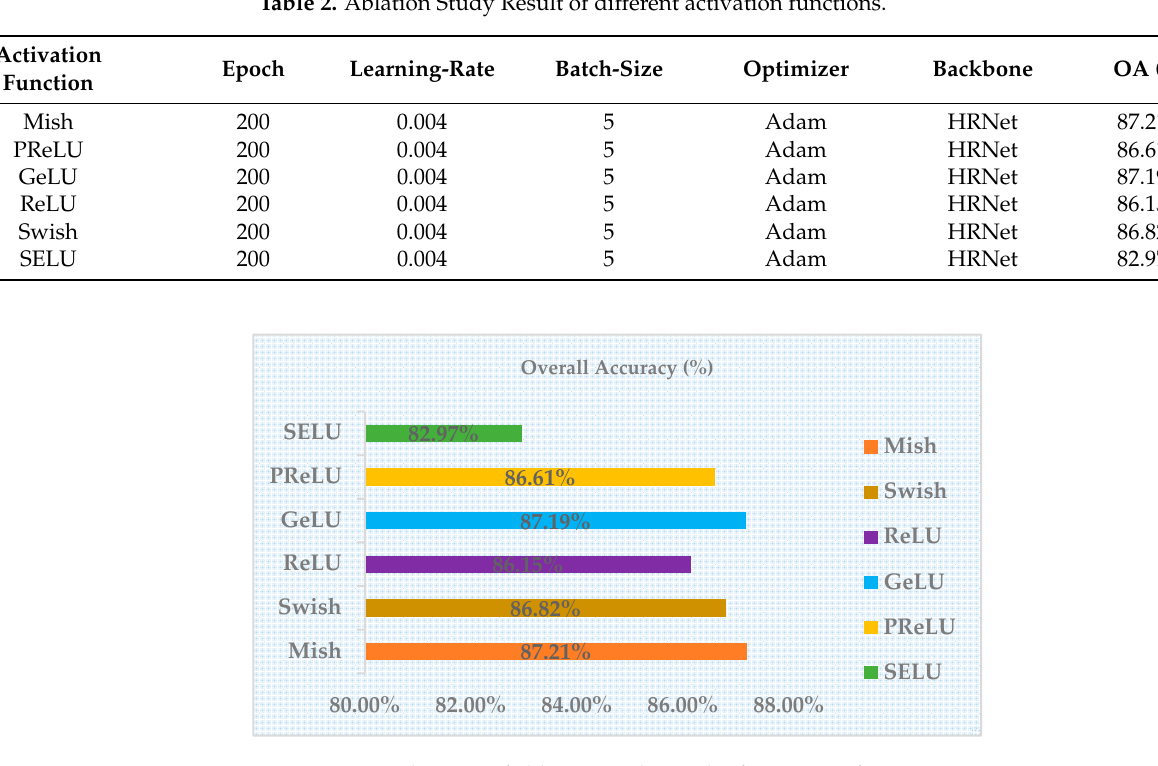
Figure 13. Visualization of ablation study result of activation functions.